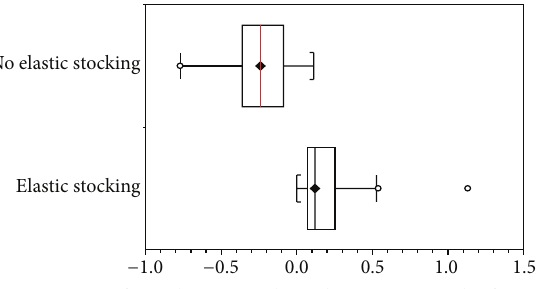
Figure 1: Box whisker plot showing leg volume changes between Mechanical Lymphatic Therapy sessions comparing patients who used elastic stockings with those without any type of